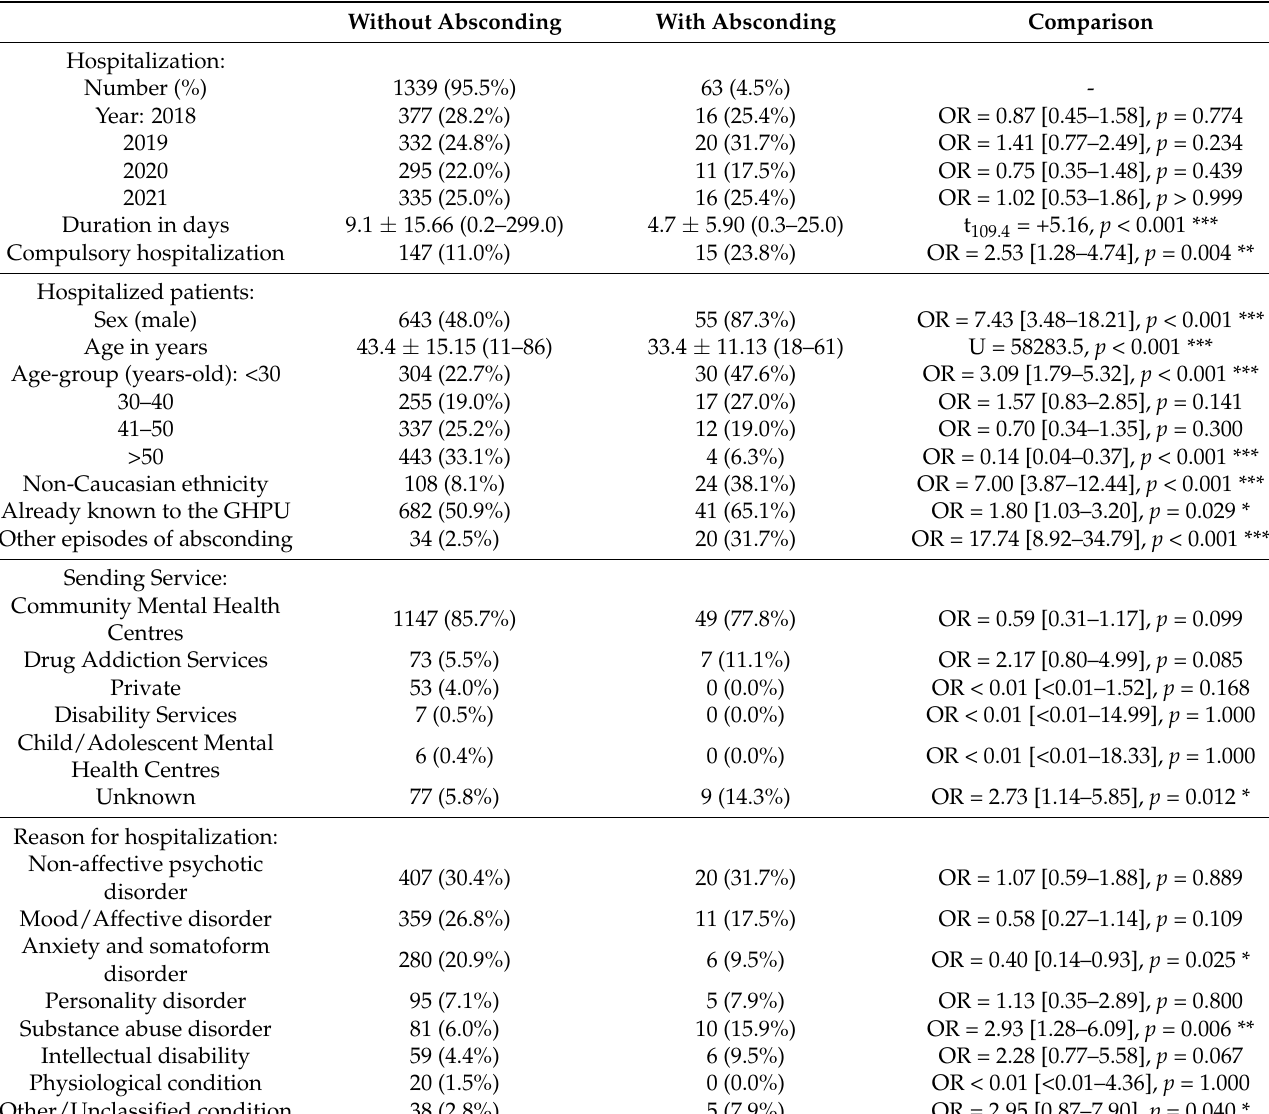
Table 1. Hospitalization characteristics over the study period